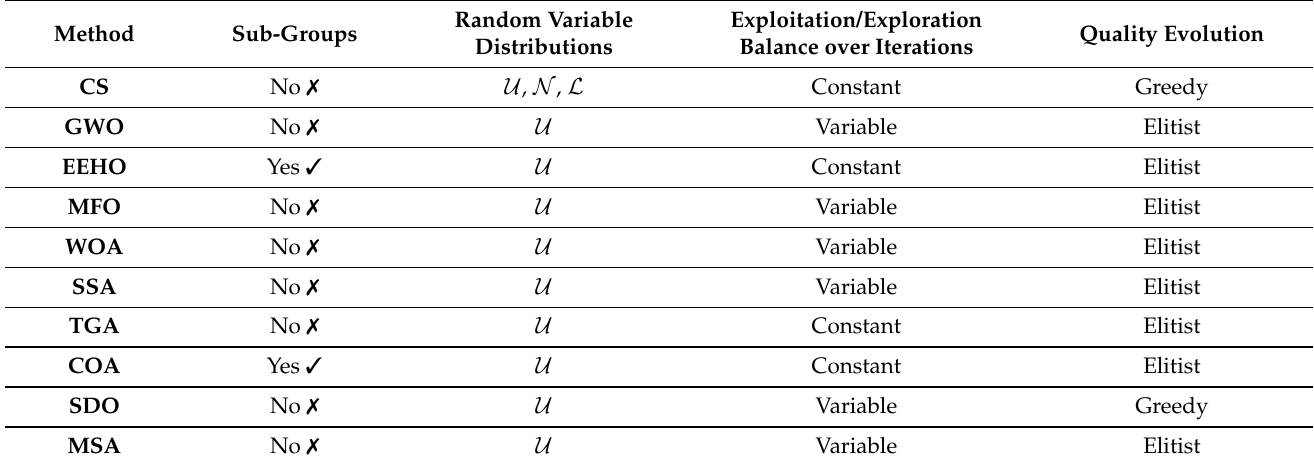
Table 4. Comparison of the algorithms’